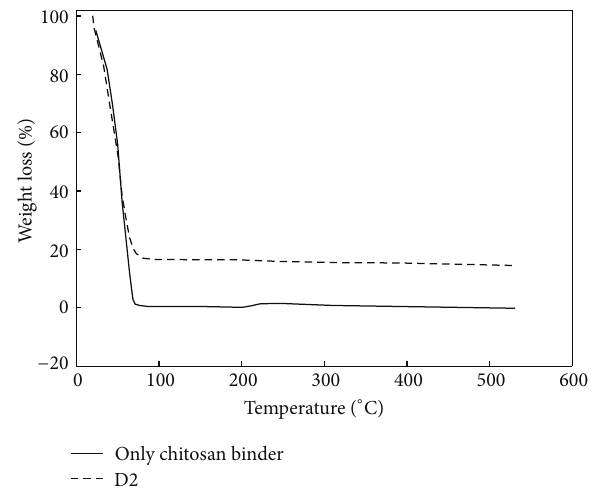
Figure 1: Thermal weight loss (TGA) curve of the pure chitosan sol (2.0%) and chitosan sol-based TiO 2 paste